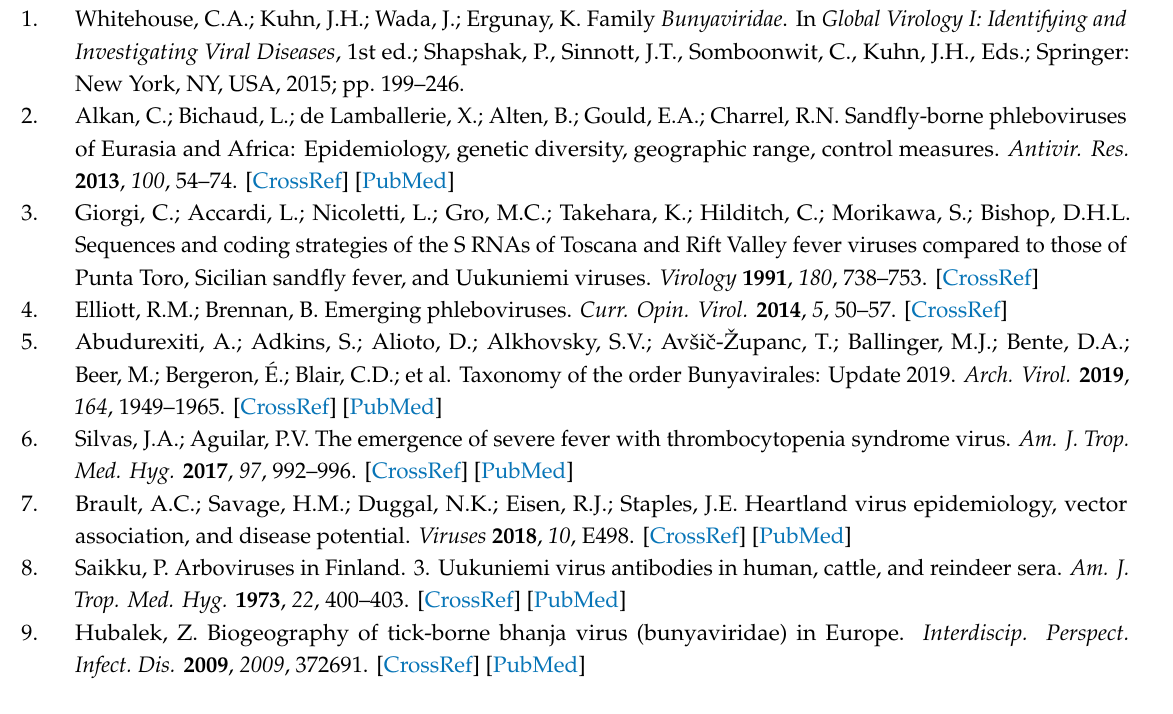
Table S1: Distribution of tick species according to collection site, sex, and developmental stage. Table S2: Features of the tick pools positive in screening and evaluated using NGS. Figure S3: The maximum likelihood analysis of the partial tick phlebovirus L segment sequences (707 bp). The tree is constructed using the General Time Reversible (GTR) model, Gamma distributed with Invariant sites (G + I) for 500 replications. The sequences characterized in this study are given in bold and indicated with a symbol (red diamond), GenBank accession number, and pool code. Global virus strains are indicated by GenBank accession number and strain / isolate name. Viruses previously characterized in Turkey are indicated with green circles. Bootstrap values higher than 80 are provided. Figure S4: The maximum likelihood analysis of the partial tick phlebovirus L segment sequences (347 bp). The tree is constructed using the General Time Reversible (GTR) model, Gamma distributed with Invariant sites (G + I) for 500 replications. The sequences characterized in this study are in bold with the GenBank accession number and pool code. Global virus strains are indicated by GenBank accession number and strain / isolate name. Bootstrap values higher than 80 are provided. Figure S5: Alignment of the phlebovirus RNA-dependent RNA polymerase conserved regions other than region III, as located on the amino acid residues 107–131 (Region I), 673–731 (Region II), 1225–1324 (Region IV), 1420–1458 (Region V), and 1551–1646 (Region VI) on the Uukuniemi virus genome L segment (NP941973). GenBank accession and sequence information on individual strains used in comparison are provided in Figure